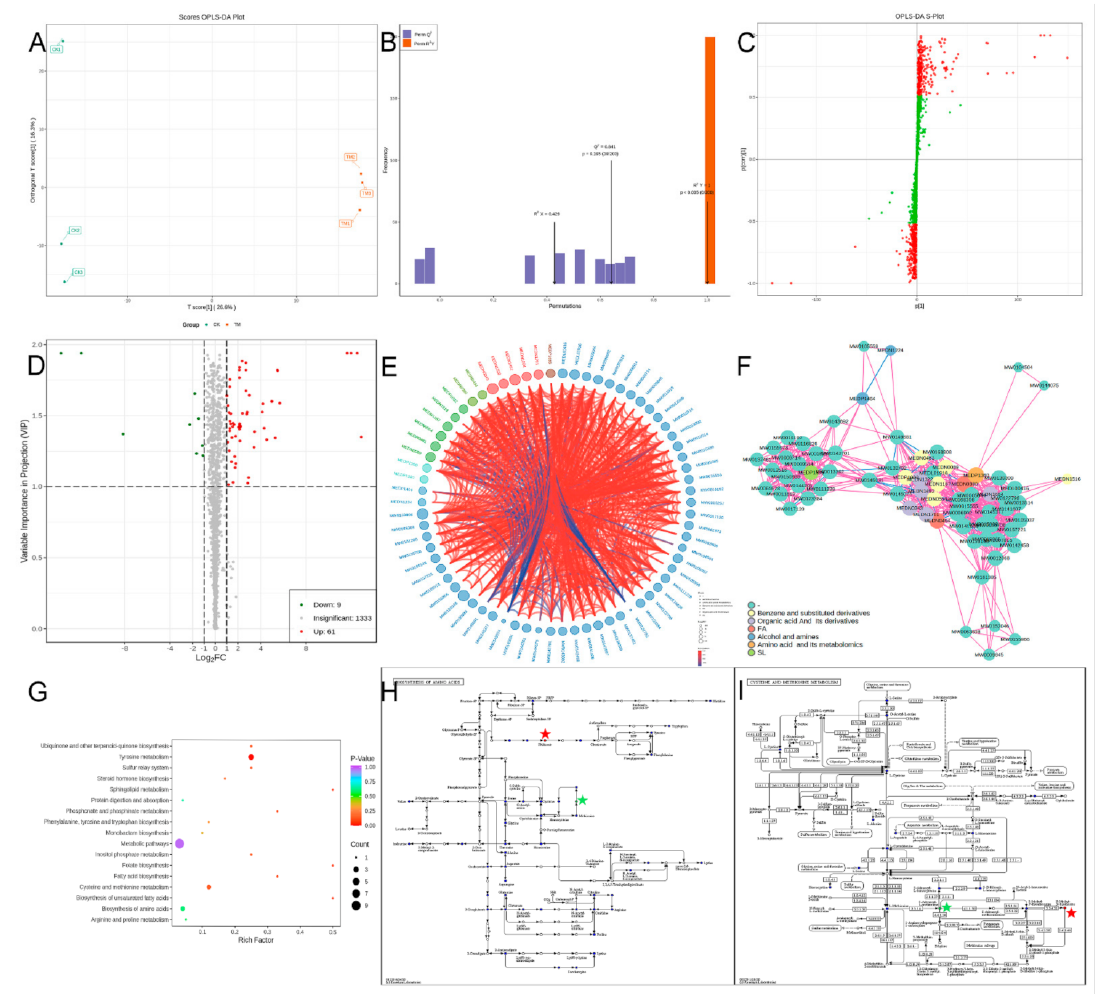
Figure 6. Metabolite’s analysis of HBA-treated A. avenae subsp. citrulli by LC-MS/MS. Notes: ( A ): OPLS-DA score plot; ( B ): OPLS-DA verification diagram; ( C ): OPLS-DA S-plot; ( D ): difference metabolite volcano map; ( E ): difference metabolites and dazzle diagram; ( F ): difference metabo- lite network diagram; ( G ): difference metabolites KEGG enrichment; ( H ): biosynthesis of amino acids difference metabolites KEGG pathway; ( I ): cysteine and methionine difference metabolites KEGG